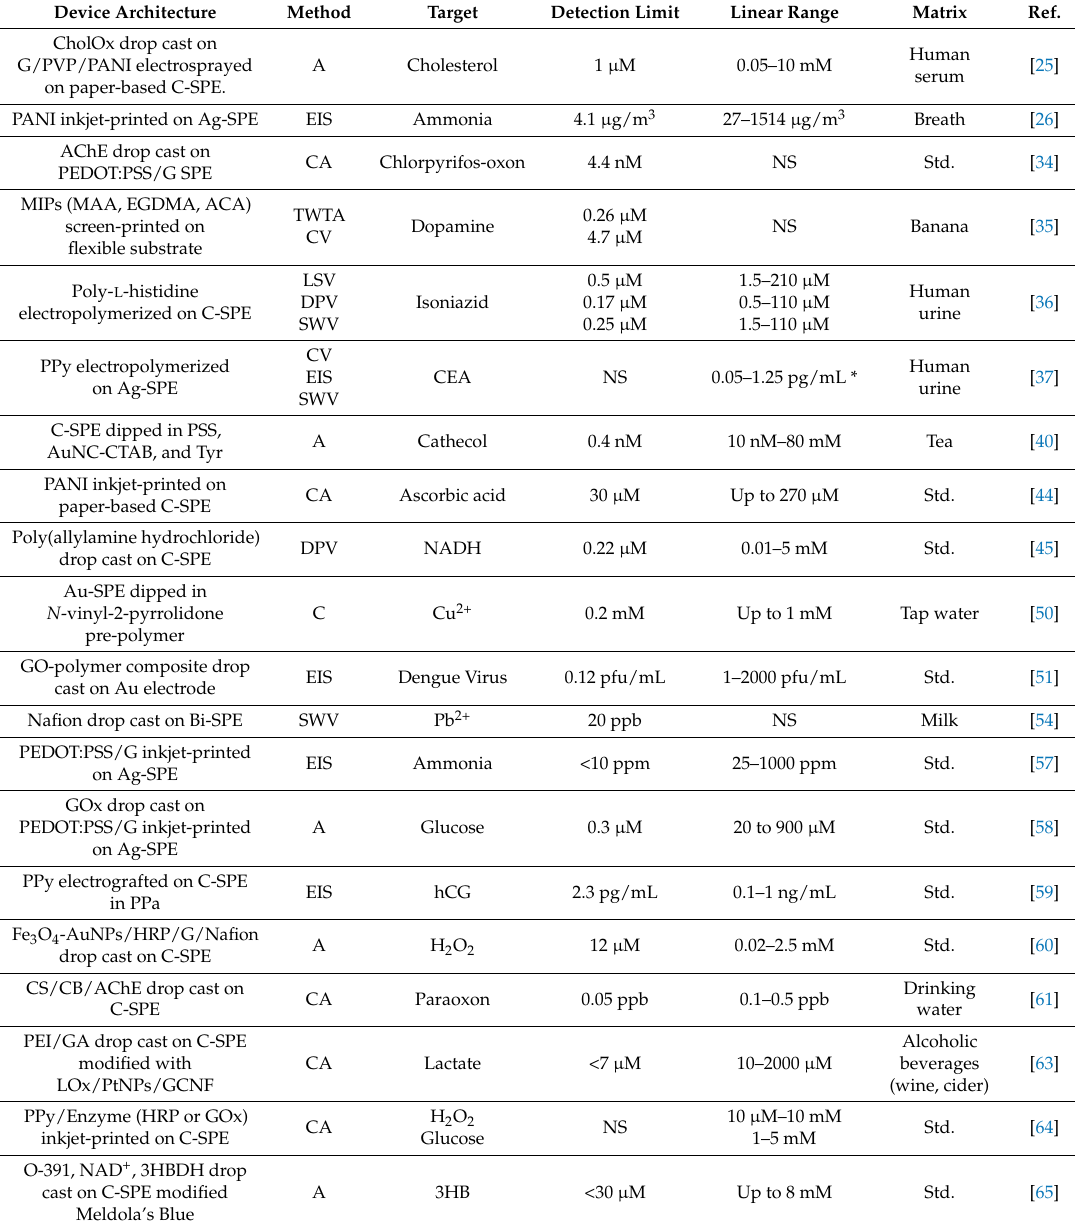
Table 1. Summary of the electrochemical-based (bio)sensors that exploit the presence of a polymeric material in their